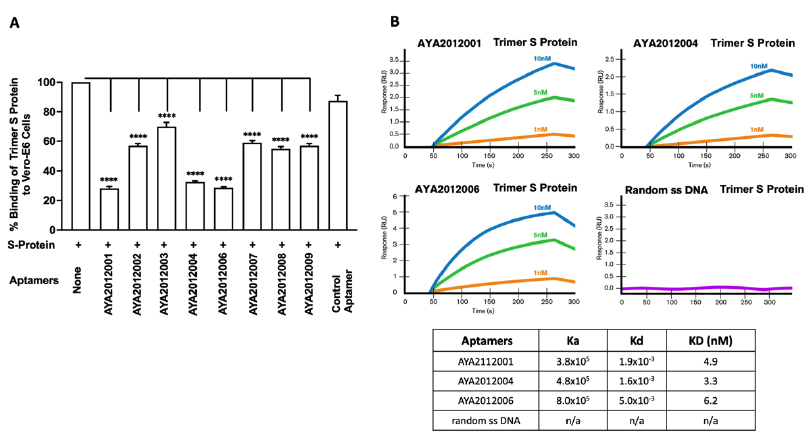
Figure 3. Aptamers’ inhibition of the binding of SARS-CoV-2 trimer S protein to ACE2 receptors expressed on the surface of Vero E6 cells. ( A ) Inhibition of binding of SARS-CoV-2 trimer S protein to ACE2 receptors expressed on the surface of Vero E6 cells. S protein at 10 nM was added to Vero E6 cells after pre-incubation with 5 µ M of the indicated aptamer. Random 40 nucleotides ssDNA was used as a control. After 1 h incubation, unbound S protein was washed out, and the cell pellet was solubilized with 1% Triton X100. The supernatant-containing solubilized His-tagged SARS-CoV-2 trimer S protein was applied to the nickel-coated plate. The His-tagged S protein bound to nickel was detected using mouse monoclonal antibodies against S protein and horseradish peroxidase- conjugated goat anti-mouse antibodies. Each value was the average of duplicate measurements. Error bars represent mean ± SD ( σ ). p -values were determined with one-way ANOVA and Dunnett’s multiple comparison test. **** denotes p < 0.0001. ( B ) Binding affinity for aptamers with the best inhibitory activity. Characterization of the affinity between aptamers AYA2012001,